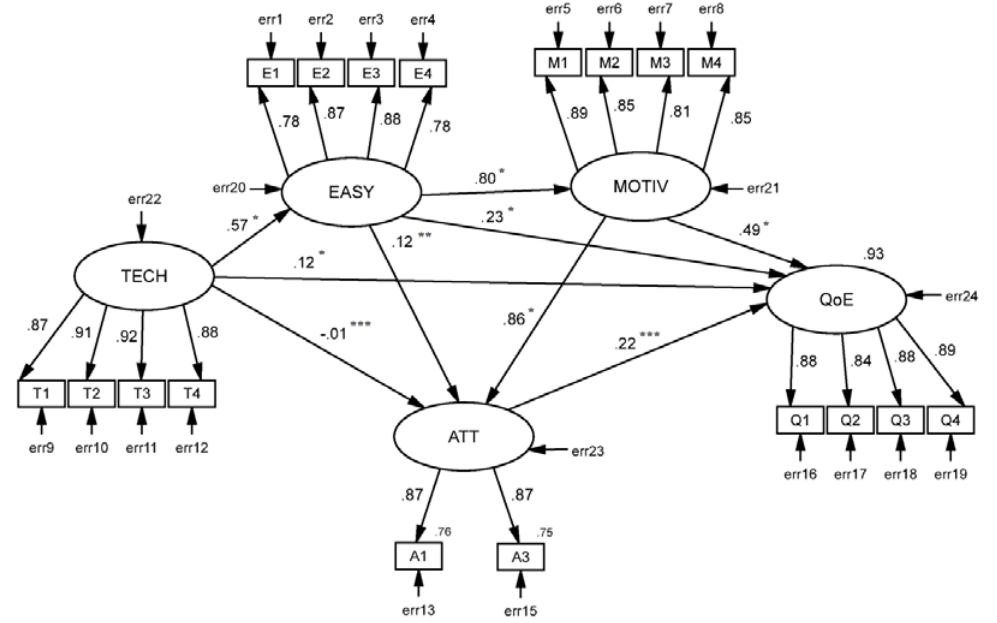
Figure 2. Structural model for QoE prediction in a synchronous learning environment (* p < 0.001, ** p < 0.05, *** p > 0.05,